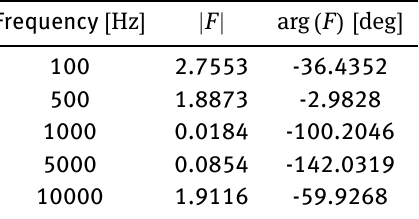
Table 2: Mean value of the modulus (middle column) and phase (right column) of the multipath factor (18) versus source distance, 700m < q < 1400m , in a fixed direction, β = 2.45 °, with rigid ground and wall, R h = R v = 1 , and observer position at ( a , b ) = (3, 2) m , adding to the frequency f = 1000Hz four others, two with larger order of magnitude and two with smaller order of